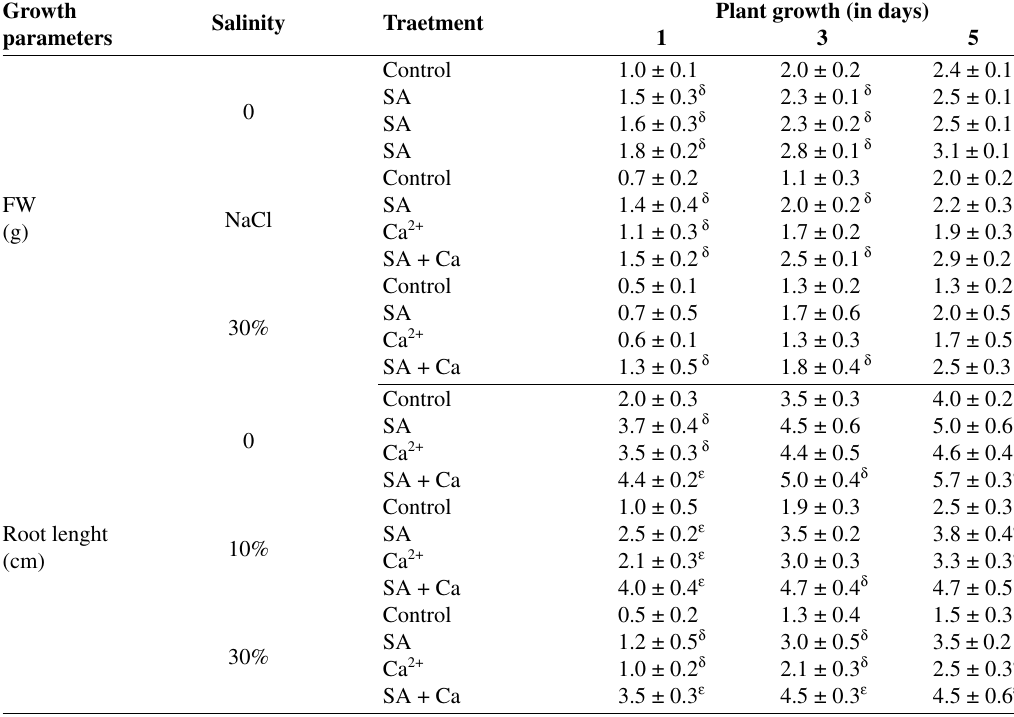
Table 2. Growth parameters: shoot and root lenght of wheat four different treatments; control, 0.5 mM SA, 50 mM Ca 2+ , and acombination of SA+Ca under non-saline and 10%-30% salinity stress.